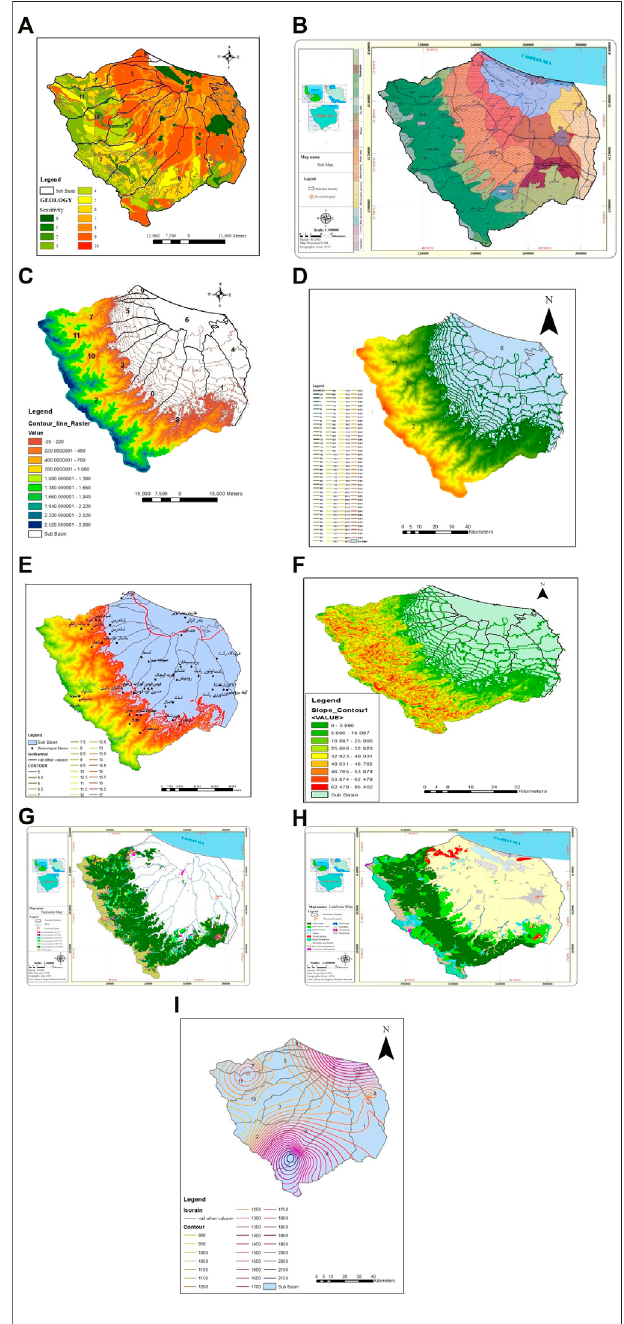
FIGURE 2 | (A) Geology, (B) Type of land, (C) Contour, (D) DEM, (E) Isotherm, (F) Slope-contour, (G) Ground cover, (H) Land use, (I)